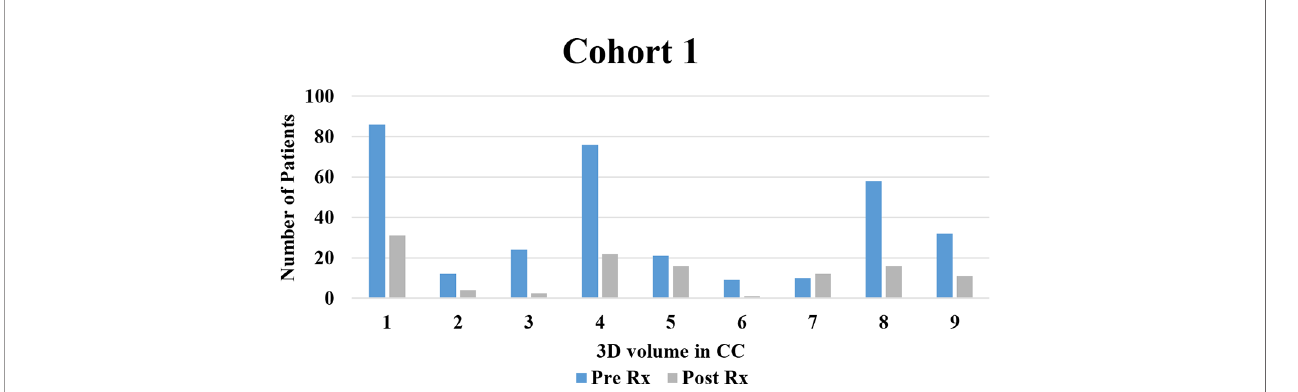
FIGURE 6 | Decreases in PDAC Volume.